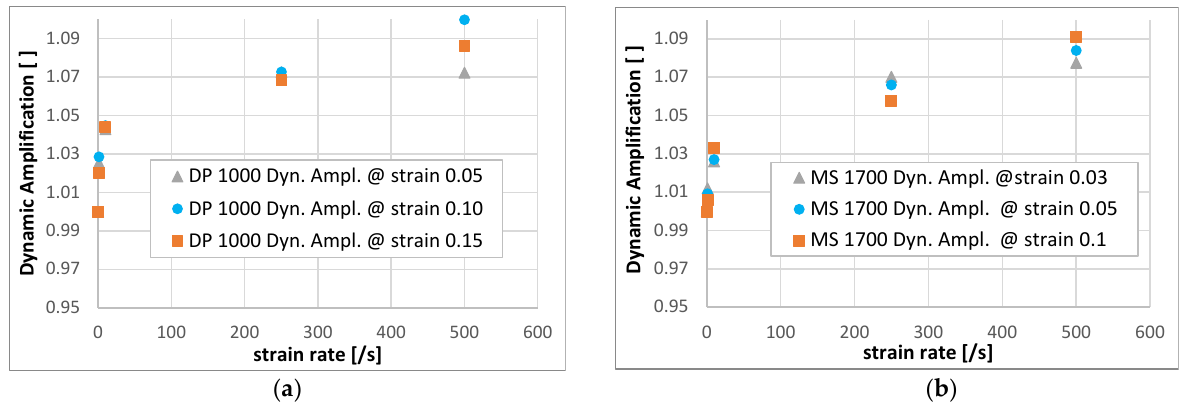
Figure 18. Dynamic amplification of DP1000 ( a ) and MS1700 ( b ) steels.